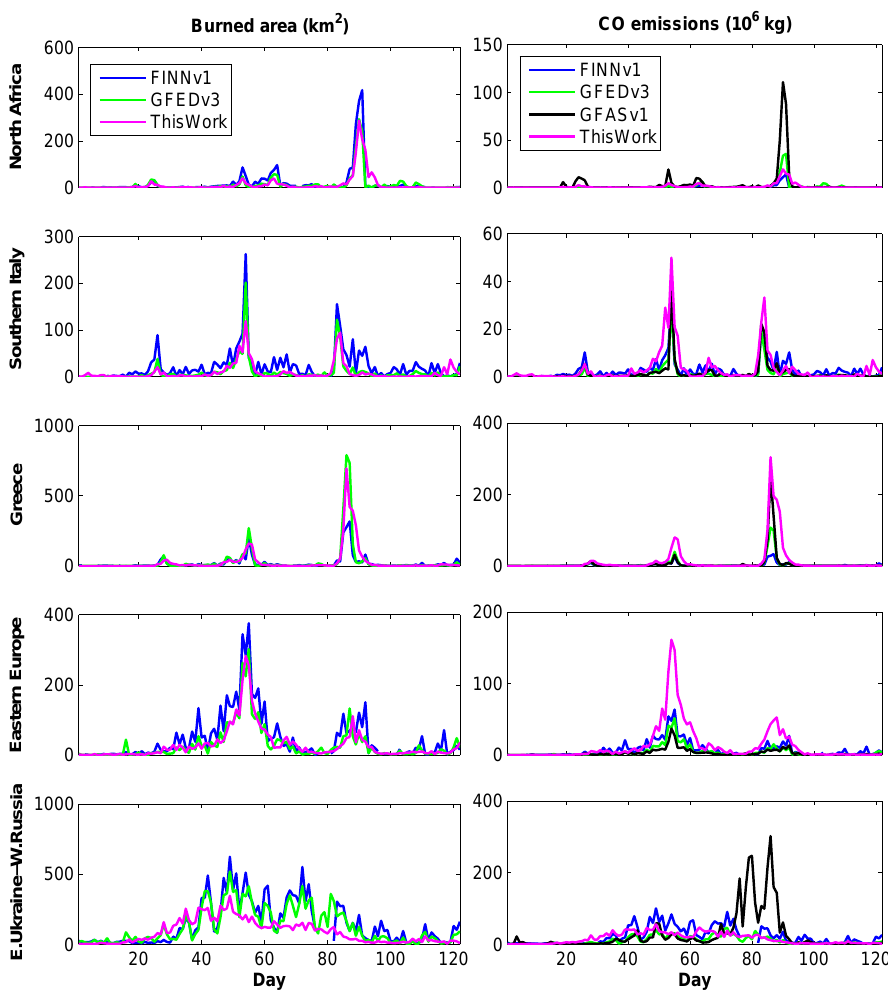
Fig. 9. Daily burned area (left) and carbon monoxide (CO) emissions (right) during the summer 2007 within subregions of Fig. 3 according to the present work and the FINN-v1 and GFED-v3 inventories. Day 1 corresponds to 1 June, and day 120 to 30 September. Detail on each inventory’s specifications is provided in Table 6.